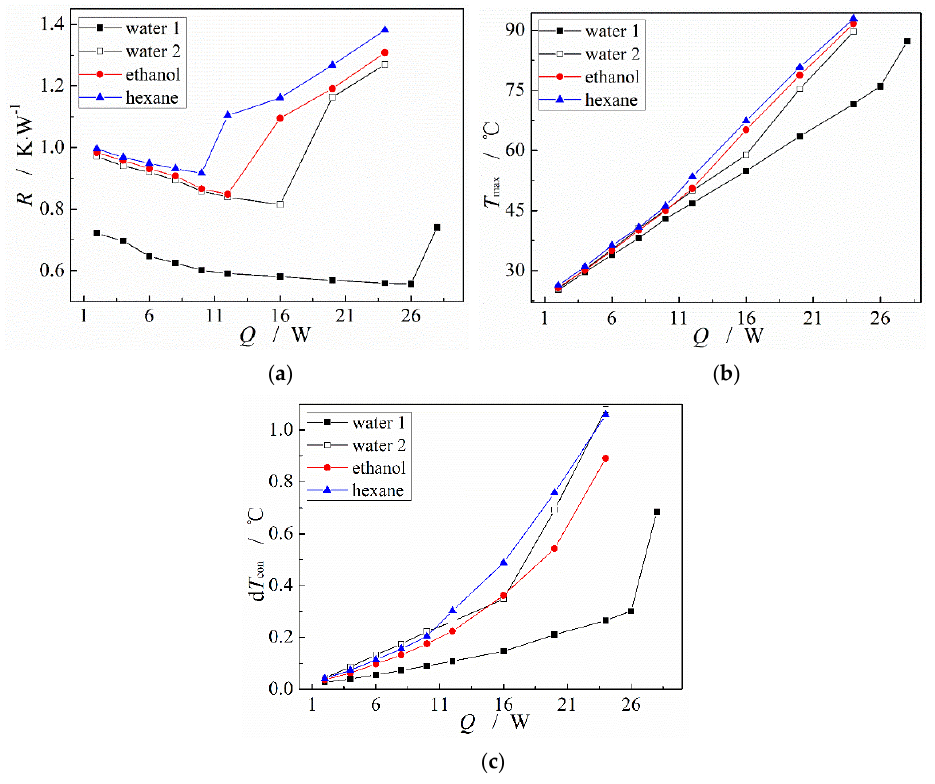
Figure 10. Heat transfer performance of the MGFHP under different input heat amounts with different working fluids: ( a ) thermal resistance; ( b ) maximum temperature at evaporation section; and ( c ) temperature nonuniformity at condensation section.